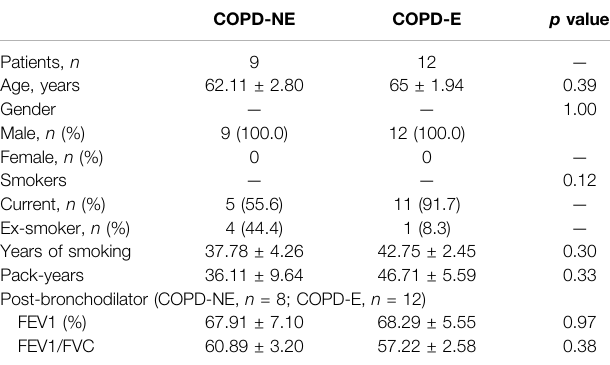
TABLE 1 | Demographic and spirometric features of the discovery cohort. TABLE 2 | Demographic and spirometric features of the validation cohort.